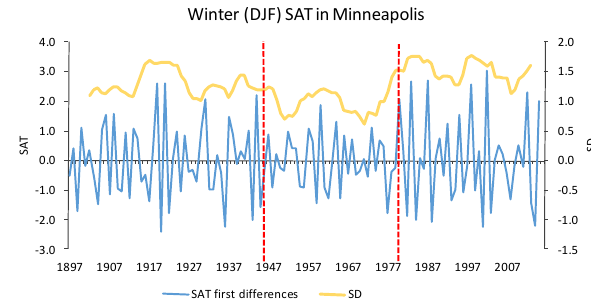
Figure 10. First differences of winter (DJF) SAT anomalies in Min- neapolis, MN, along with the 13-year-running standard deviations and two change points (1946 and 1980) detected by SRSD (0.1, 35, 3).